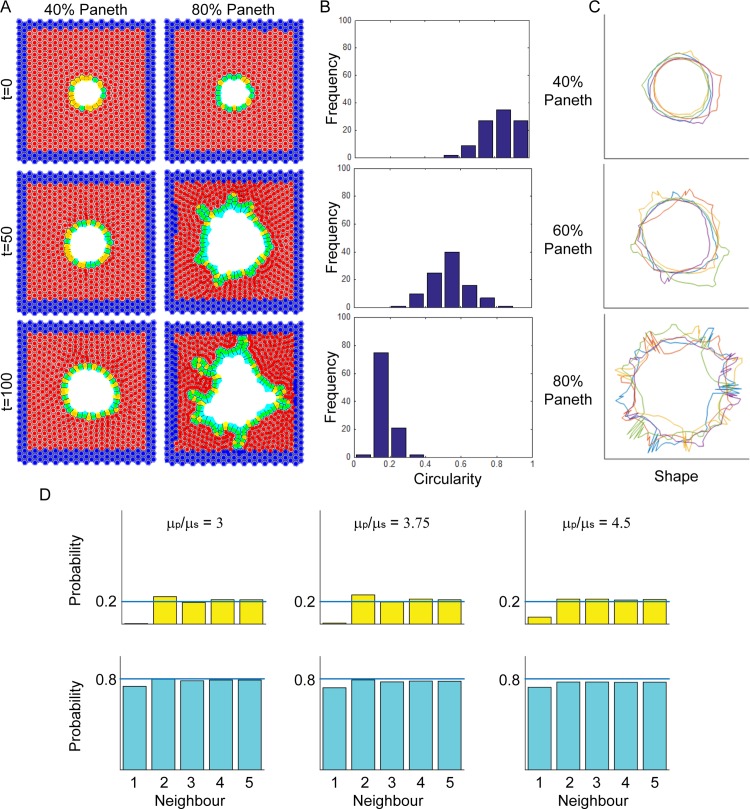
Mathematical modelling indicates Paneth cells stimulate deformation.(A) Images from a sample simulation of fission in the epithelial layer at times t = 0, 50, and 100 h. A high proportion of stiffer Paneth cells (light blue) causes buckling of the epithelial layer. Softer Lgr5+ cells (yellow) are pushed out of the initially spherical layer by neighbouring Paneth cells, leading to the formation of a bud. At later times and higher proportions, Lgr5+ cells also appear in bifurcation sites between small buds (bottom right panel). Red cells represent Matrigel or surrounding stromal cells; blue cells represent non-epithelial cells fixed around the edges. (B) Distributions of the final circularity values of the epithelial layer for different Paneth cell proportions (S11 Data). Each histogram has been plotted with ten evenly spaced bins from 0 to 1. Circularity values closer to one reflect a circular layer, while values closer to zero reflect a less regular circle, which indicates buckling of the cell layer. (C) Five representative portraits of the epithelial layers for different Paneth cell proportions. (D) Bar graphs displaying probability of a neighbouring cell being of the same type (S12 Data). Top panel shows probability of a stem cell occupying each of the five neighbouring cells to a stem cell (at position 0). Lower panel shows the same for Paneth cells. Only in cell layers where Paneth cells are 4.5-fold stiffer (μp/μs = 4.5) and crypt wall deformation occurs do two stem cells neighbour each other, apparent by neighbour 1 having a probability value >0. Underlying data for panel B can be found in S11 Data, and for panel D in S12 Data.